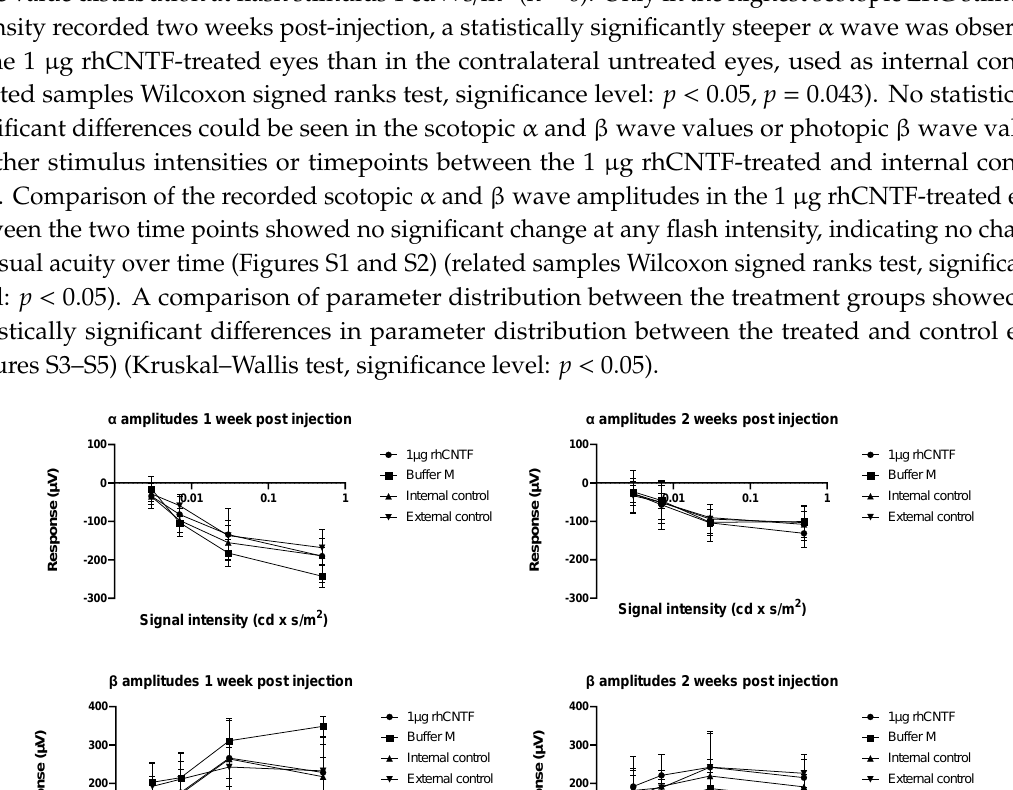
( p = 0.831) (n = between their mean values (p = 0.831) (n = 6).